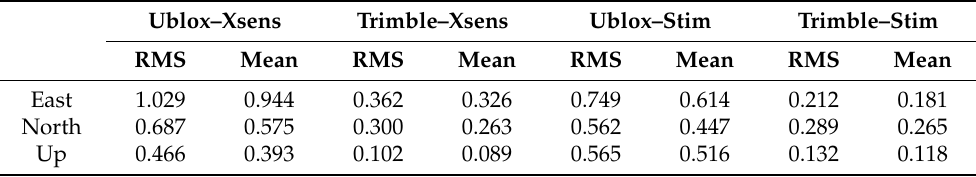
Table 7. RMS error and mean error (m) in east, north, and up directions—third field